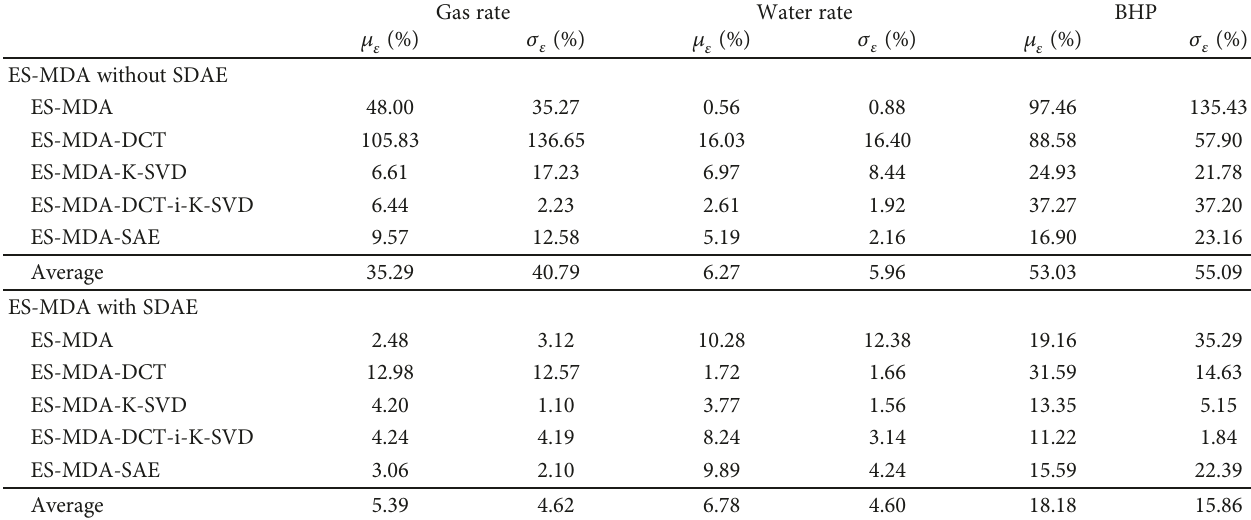
Table 8: Statistical parameters of prediction errors for gas rate, water rate, and BHP (only for the wells installed in the sand formation). μ σ ε refer to the mean and standard deviation of errors, respectively.